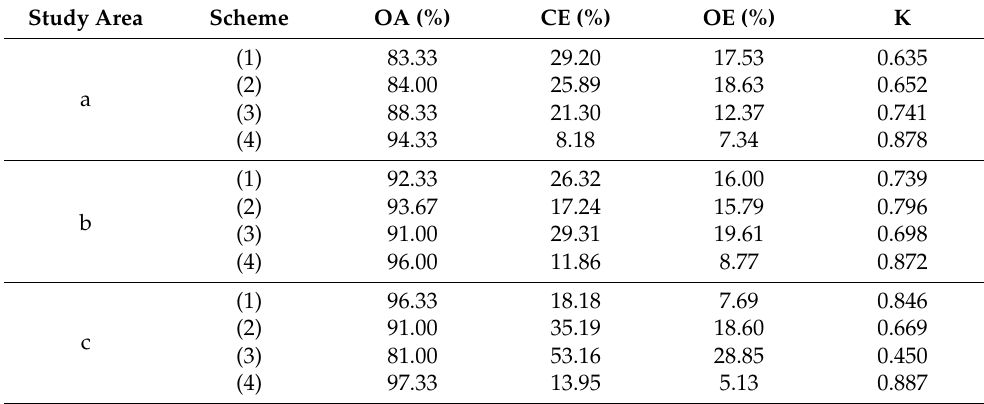
Table 4. Accuracy evaluation of the four schemes in the three study areas (( a ), ( b ), and ( c ) represent Beijing, Xi’an, and Xiamen, respectively; 1, 2, 3, and 4 represent the schemes in Table 3). Study Area